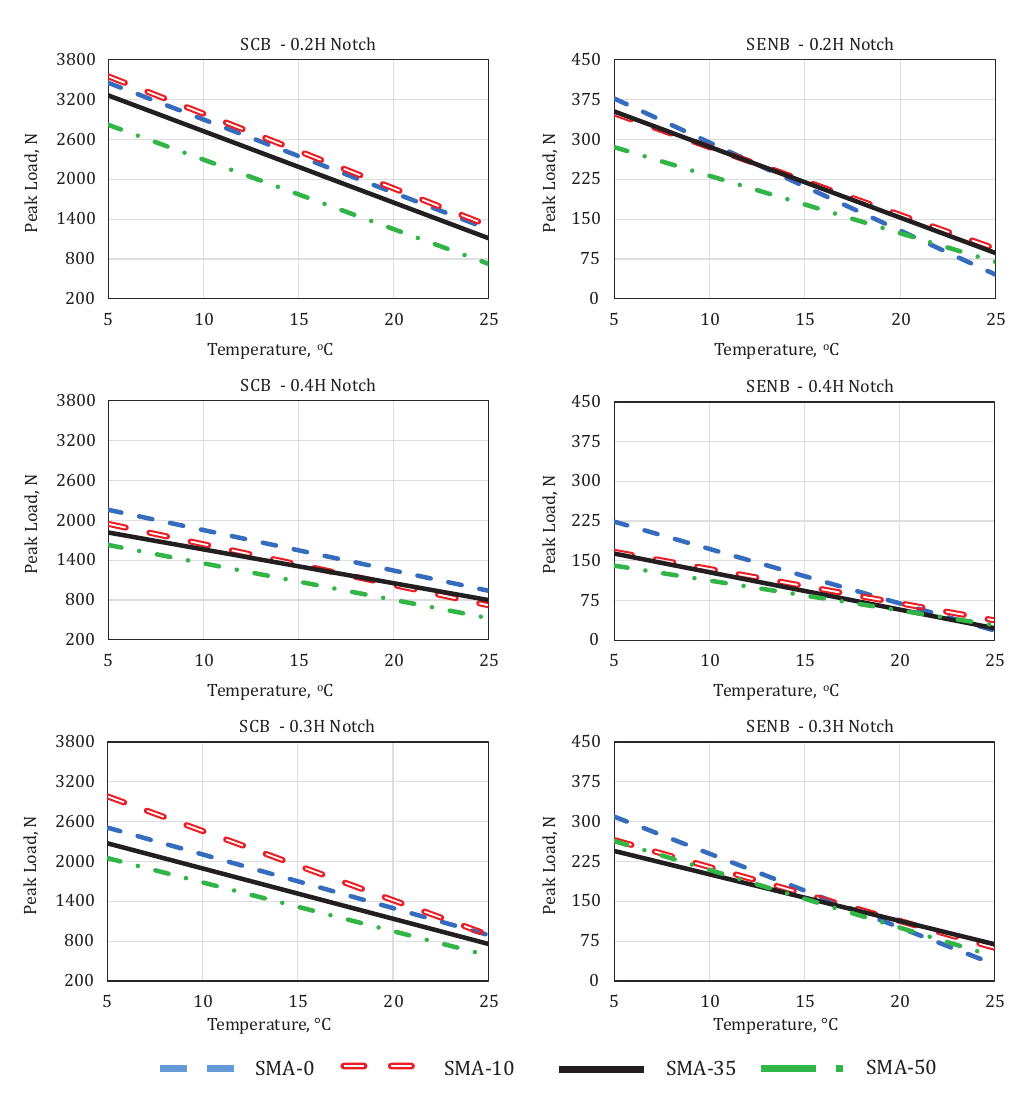
Figure 10. Peak load vs. temperature for varying notch